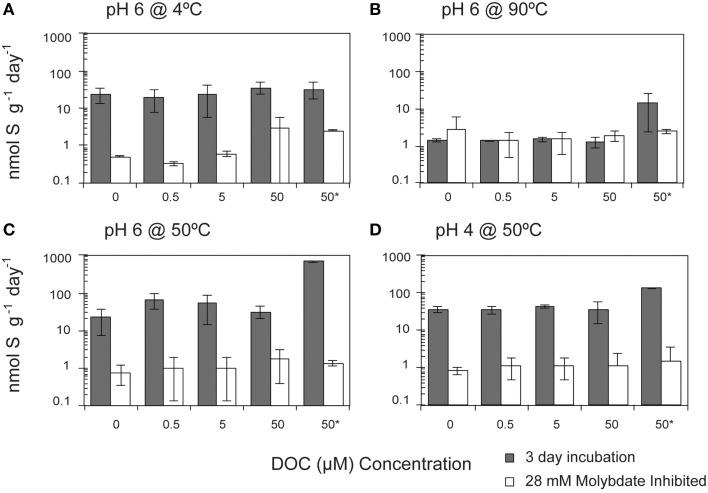
Effect of dissolved organic carbon (DOC) concentrations on sulfate reduction rates. The crushed flange from the Grotto hydrothermal deposits were incubated for 3 days () in media of (A) pH 6 at 4°C, (B) pH 6 at 90°C, (C) pH 6 at 50°C, and (D) pH 4 at 50°C. While most of experiments were performed in laboratory using stored samples, concentrations identified with an asterisk (*) were done shipboard immediately after collection of hydrothermal chimney. 28 mM molybdate amended samples were incubated under all conditions (□) as controls. Error bars represent 1 standard deviation. Note the log scale on the y-axis.